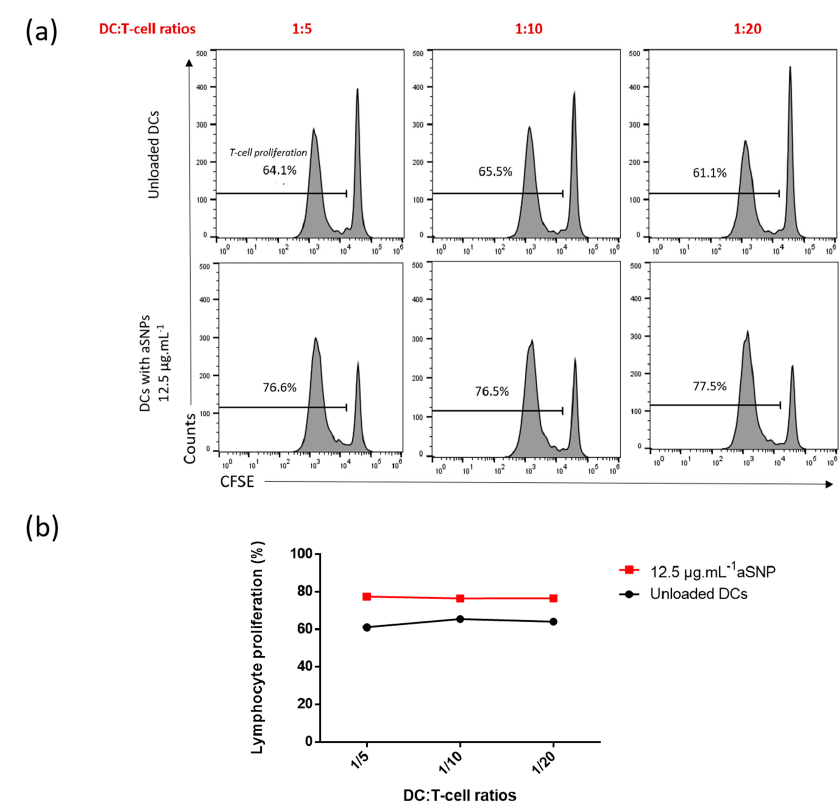
Figure 4. Lymphocyte proliferation reached a plateau at high ratios after 6 days of co-culture. Cells were incubated in the presence or absence of 12.5 µg.mL − 1 of aSNP for 16 hours. Treated MoDCs were co-cultured with allogeneic CD4+ T-cells labeled with CFSE at the ratios of 1:5 (1 MoDC per 5 CD4+ T-cells), 1:10 and 1:20). Proliferation was quantified after 6 days of co-culture as the percentage of CFSE low CD4+ T-cells. Untreated DCs were used as negative control. Results are shown as percentage of lymphocyte proliferation using FACS histogram ( a ) or curve ( b ) for a representative experiment. To tackle this issue, we kept the 1:20 ratio that emerged as the most appropriate in the previous experience and added the 1:50 (1 MoDC per 50 T-cells) and 1:100 (1 MoDC per 100 T-cells) ratios (Figure 5). First, we observed that reducing the DC:T-cell ratios from 1:20 to 1:100 decreased the basal proliferation from 74.4% to 44.9% (Figure 5a). With the latter value being far below the saturation threshold, the effect of NP on T-cell proliferation was better assessed. Indeed, at the ratio of 1:20 the NP-induced proliferation increase was about 7.9% whereas it reached 19.2% for the 1:100 ratio (Figure 5a). With this latter ratio, the sensitivity noticeably increased (Figure 5b). Altogether, these results underline the importance of systematically testing at least three ratios for each experiment. These observations also demonstrate the interest of low ratios. There are only few studies using the co-culture of T-cells and DCs to assess the functional DCs maturation in presence of NP, concerning carbon black [19] and CeO2/TiO2 [23] NP. Koike et al [19] demonstrated that murine BM-DC treated with carbon black NP could enhance T-cell proliferation in a MLR-test. The authors used two ratios: 1.25% (2.5 × 10 3 DC for 2 × 10 5 T cells) and 2.5% (5 × 10 3 DC for 2 × 10 5 T cells) which reached a saturation threshold, especially for 56 nm carbon black NP [19]. A third ratio, for example 5%, would have probably increased the sensitivity of the method. Schanen et al. [23] used human DCs and naive T-cells with a single optimized ratio of 1:400. They observed that TiO2 NP had a modest immunostimulatory effect on T-cells, leading them to the co-administration of the mitogens